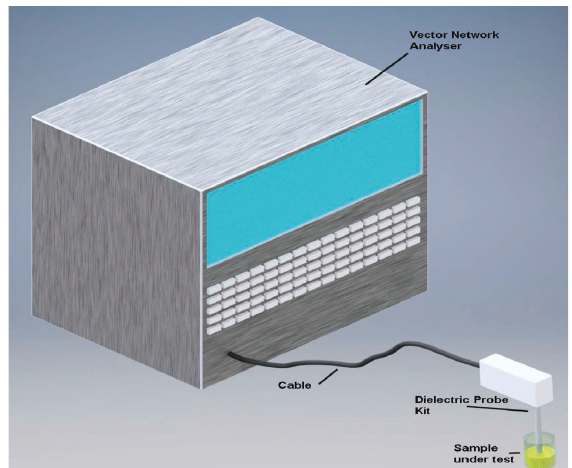
Figure 1: Representation of the vector network analyzer (VNA) (N5230A PNA-L) with the sample under